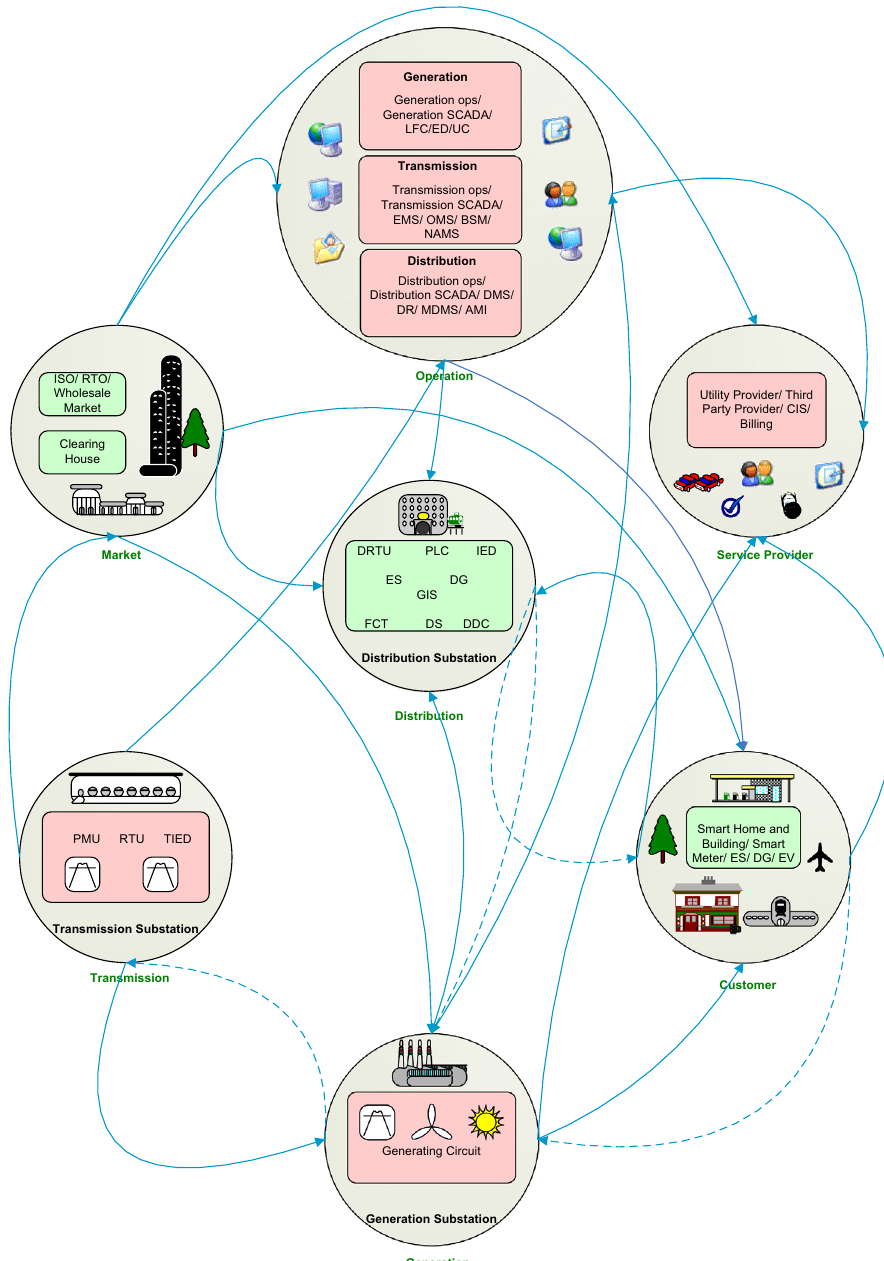
Fig. 10 Revised smart grid conceptual model by National Institute of Standard and Technology [29]. PMU, Phasor Measurement Unit; T-RTU, Transmission Remote Terminal Unit; TIED, Transmission Intelligent Electronic Device; ISO, Independent System Operator; RTO, Regional Transmission Organization; LFC, Load Frequency Control; ED, Economic Dispatch; UC, Unit Commitment; EMS, Energy Management Systems; OMS, Outage Management Systems; BSM, Bulk Storage Management; WAMS, Wide-Area Management System; DMS, Distributed Management System; DR, Demand Response; MDMS, Meter Data Management System; AMI, Advance Metering Infrastructure; CIS, Customer Information System; ES, Energy Storage; DG, Distributed Generation; EV, Electric Vehicle; D-RTU, Distributed Remote Terminal Unit; PLC, Programmable Logic Circuit; IED, Intelligent Electronic Device; GIS, Geographic Information System; FCT, Field Crew Tool; DS, Distributed Sensor; DDC, Distributed Data